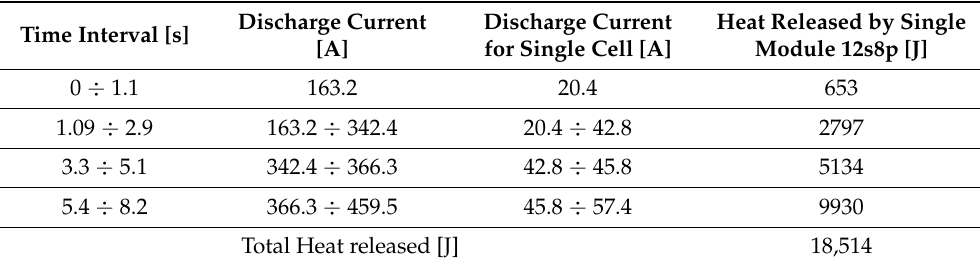
Table 8. Discharge current of the battery pack and single cell and single module heat released during the 0–200 km/h acceleration simulation